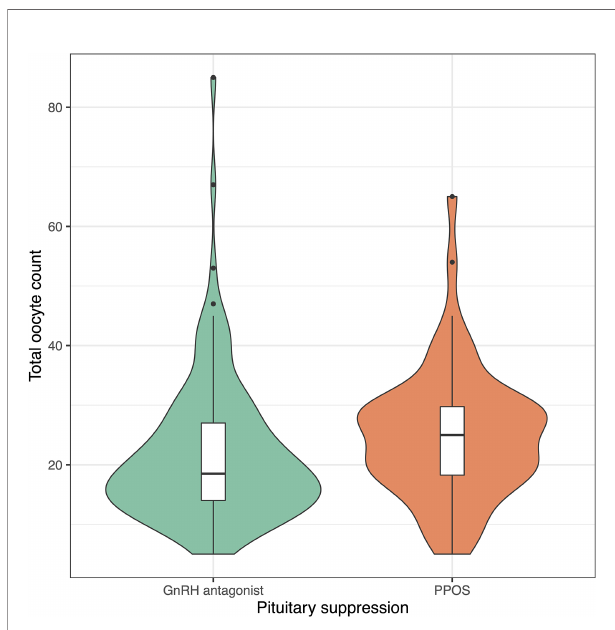
FIGURE 1 | Violin plots showing maturation rate in cycles suppressed with GnRH antagonists (green) and progestins (orange). Colored shaded areas show the distribution density. Lower and upper bounds of box plots show the interquartile range, and horizontal dash shows the median. Black dots show potential outliers. GnRH, gonadotrophin-releasing hormone; PPOS, progestin- primed ovarian stimulation.